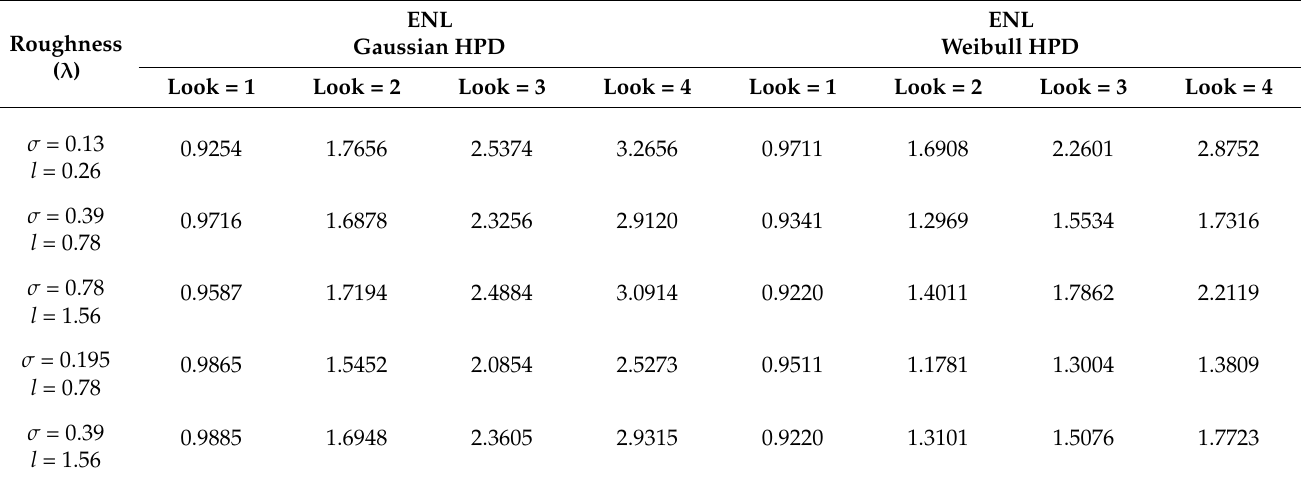
Table 5. The ENL of 1~4 looks estimated for Gaussian and Weibull surfaces at various roughness parameters (RMS height and correlation length). The SAR look angle is 72 ◦